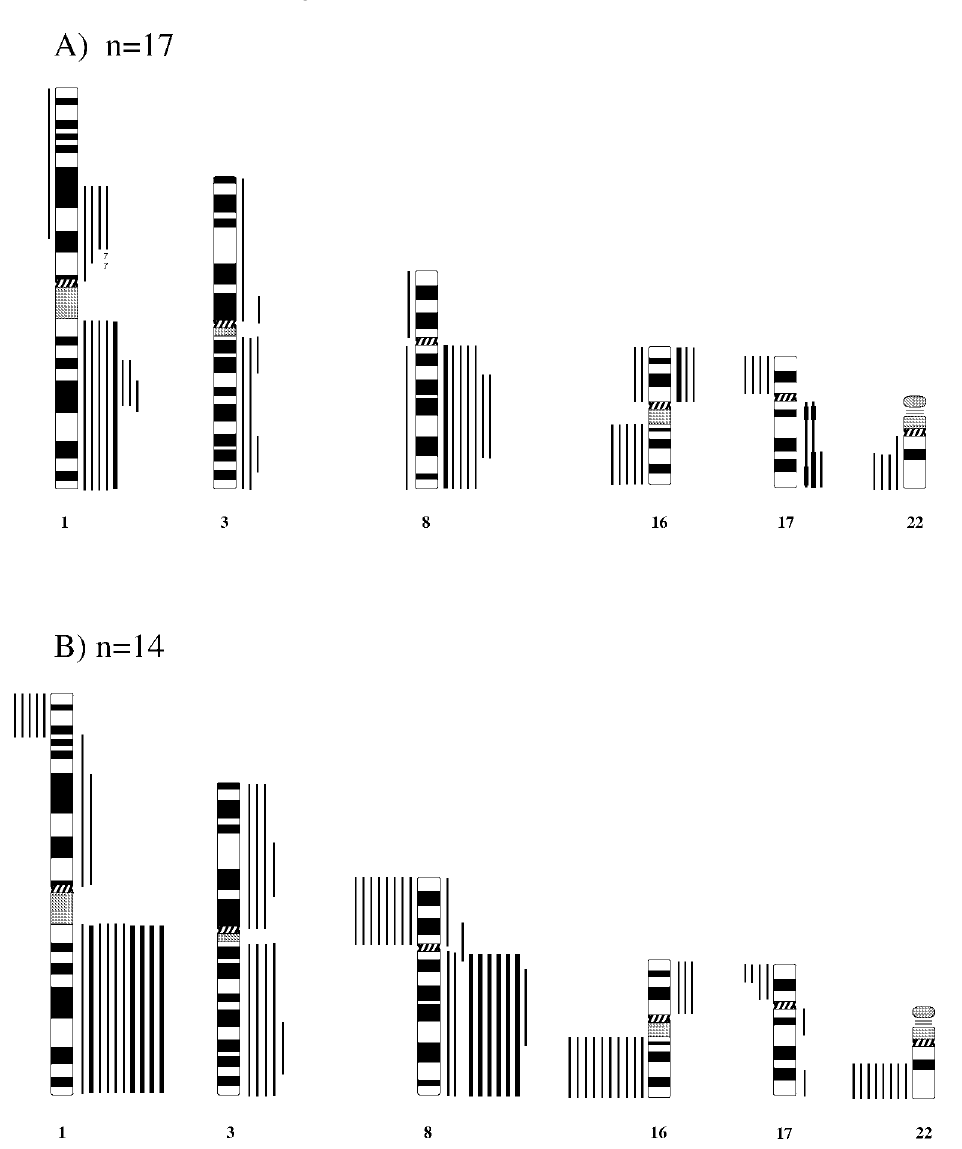
Fig. 4. Karyogram of chromosomal gains and losses in primary breast carcinomas (A) and in loco-regional recurrences/lymph node metastases (B) in patients with long-term survival. Bars on the right side of the chromosome ideogram indicate gains and bars on the left side indicate loss of genetic material. Solid bars denote high level copy number increases